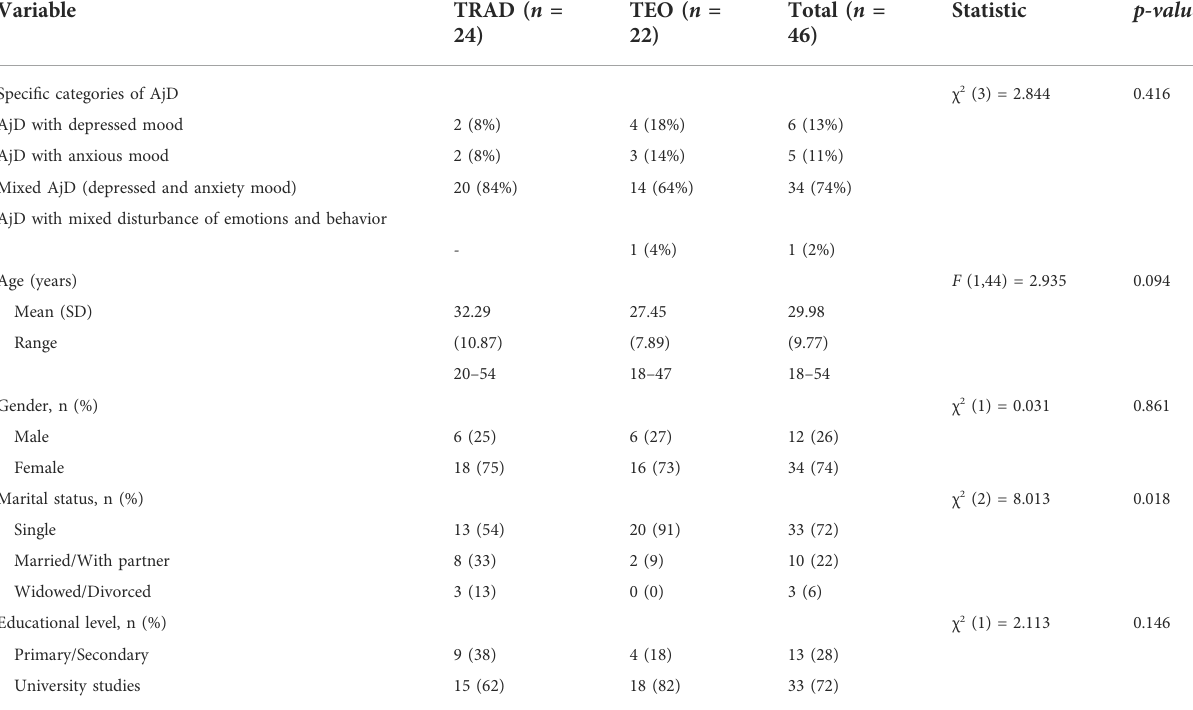
TABLE 1 Sociodemographic variables of the two experimental groups and the total sample at pre-treatment.